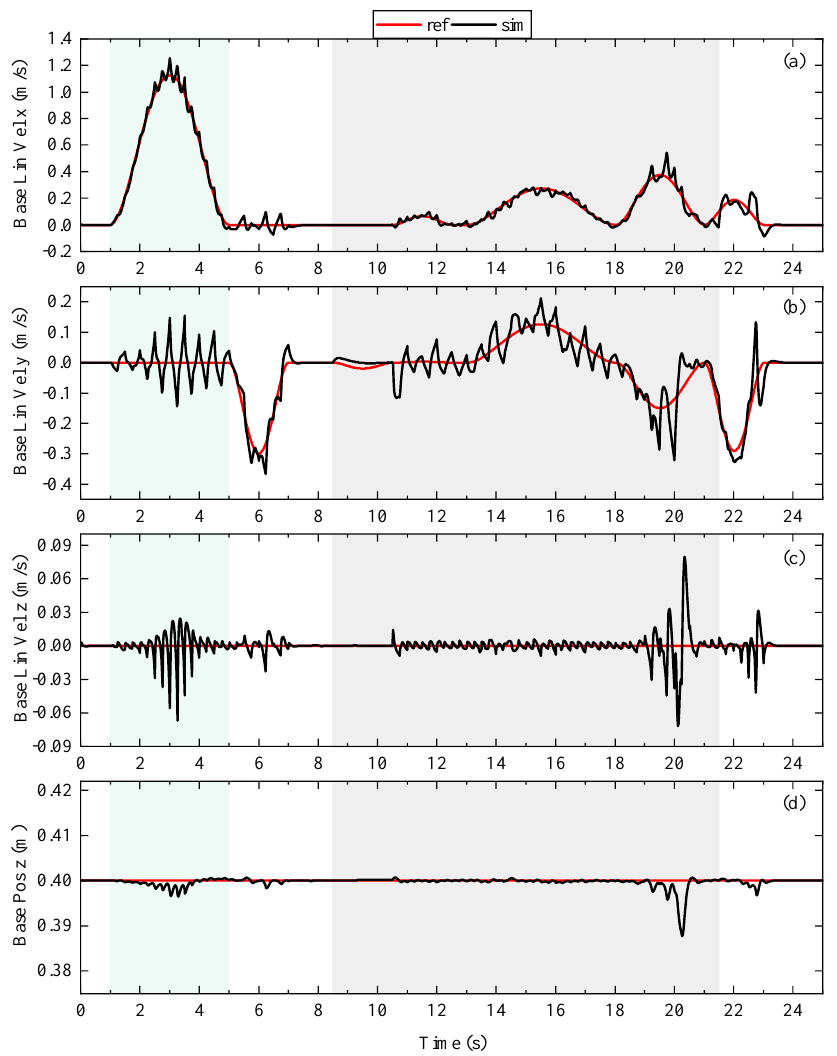
Figure 11. The time evolution of the base linear velocity and base height. Graphs ( a – c ) are the linear velocity tracking in the x-, y- and z-direction, and these velocities are expressed in the world frame. Graph ( d ) is the base height tracking. The green area indicates the process of approaching the door. The gray area indicates the time duration of manipulating the